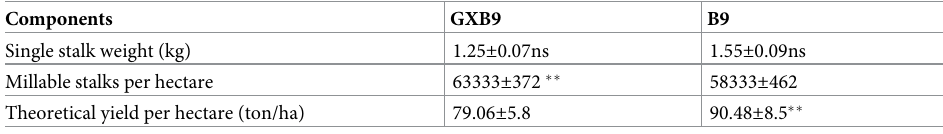
Table 8. Theoretical cane yield and its components in GXB9 and B9.